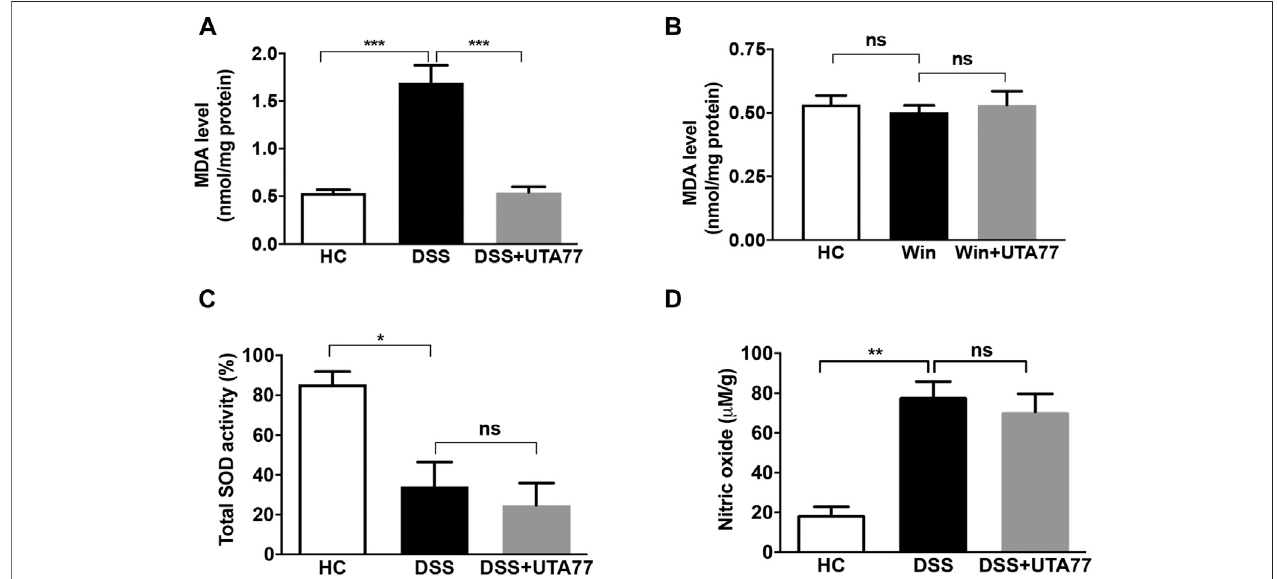
FIGURE11| EffectofUTA77onoxidativestressmarkersinacuteandchroniccolitis. (A) Malondialdehyde(MDA)levelsindistalcolonofacutecoliticmice, (B) MDA level in distal colon of Winnie mice, (C) total SOD activity in distal colon of acute colitic mice, and (D) nitric oxide (NO) levels in distal colon of acute colitic mice. Data expressed as mean ± SEM ( n (cid:1) 3/group) using one-way ANOVA followed by Tukey ’ s posttest, where *p < 0.05, **p < 0.01, ***p < 0.001, and ns: nonsigni fi cant.